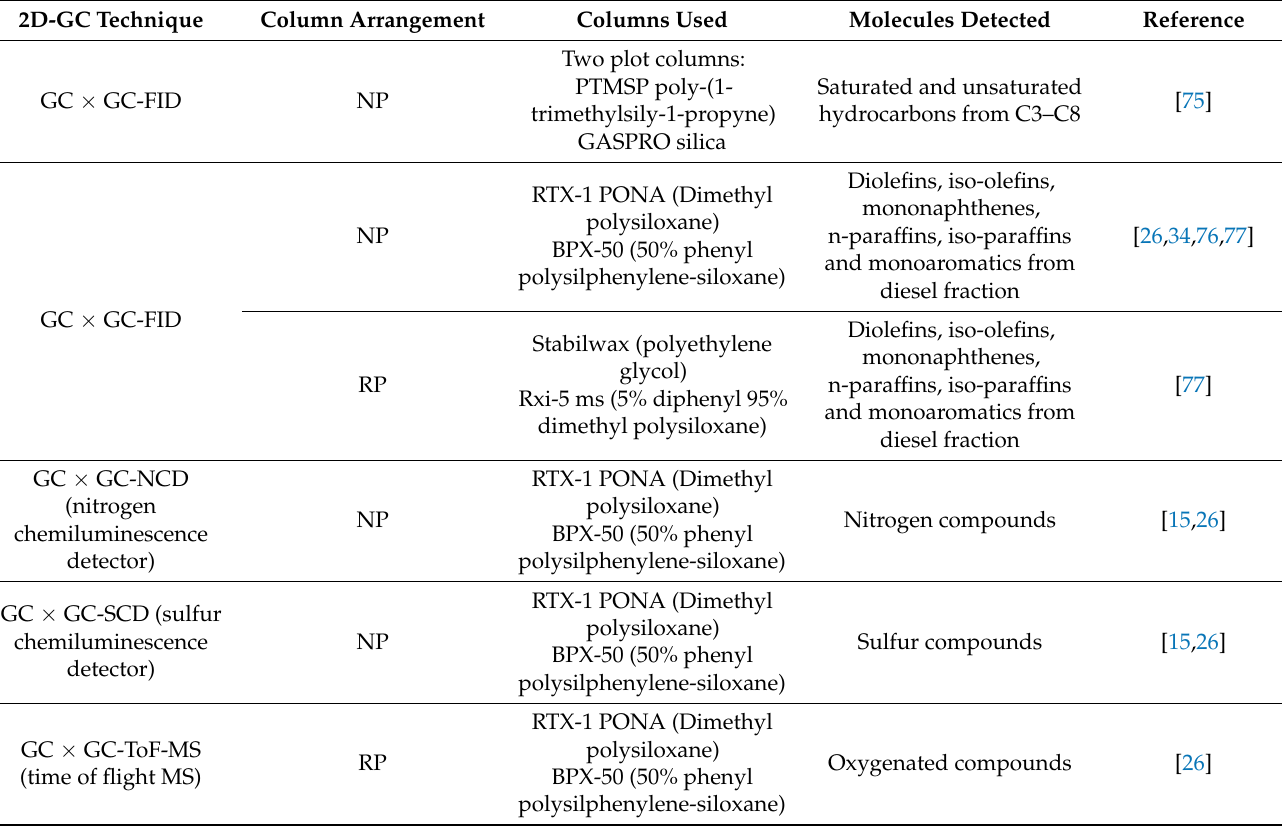
Table 6. GC × GC coupled with different detectors, for the characterization of PPO. 2D-GC Technique Column Arrangement Columns